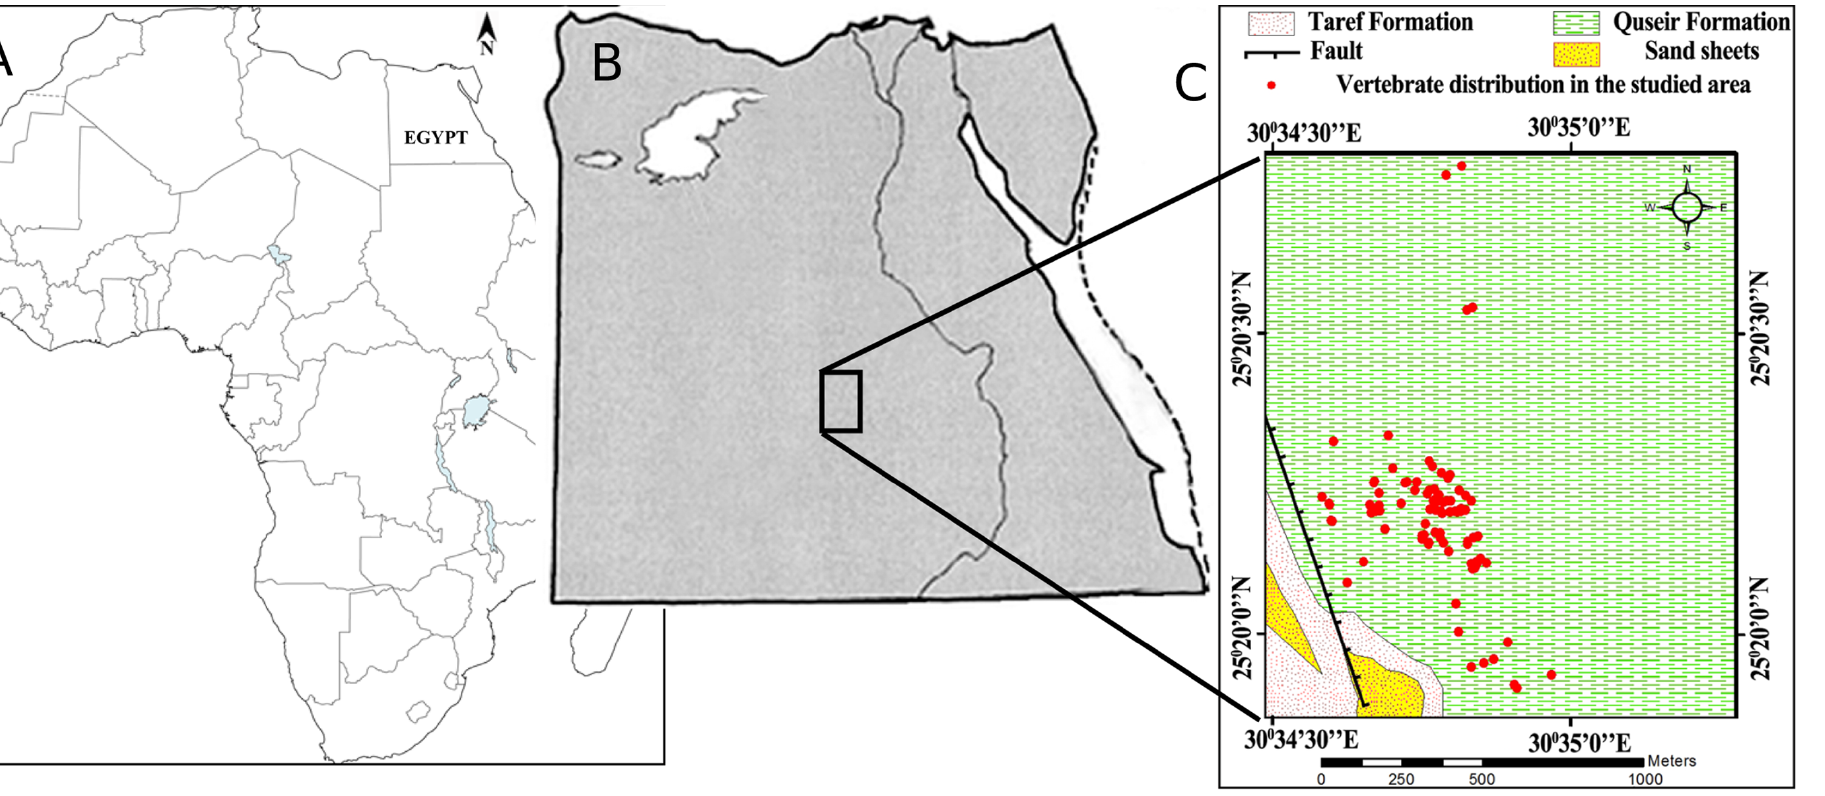
Figure 1. Map of Africa showing the location of Egypt ( A ); map of Egypt showing the location of the studied area in a rectangle ( B ) and a detailed map for the studied area showing the vertebrate distribution east of Gennah village in Kharga Oasis, Southwestern Desert, Egypt ( C ).